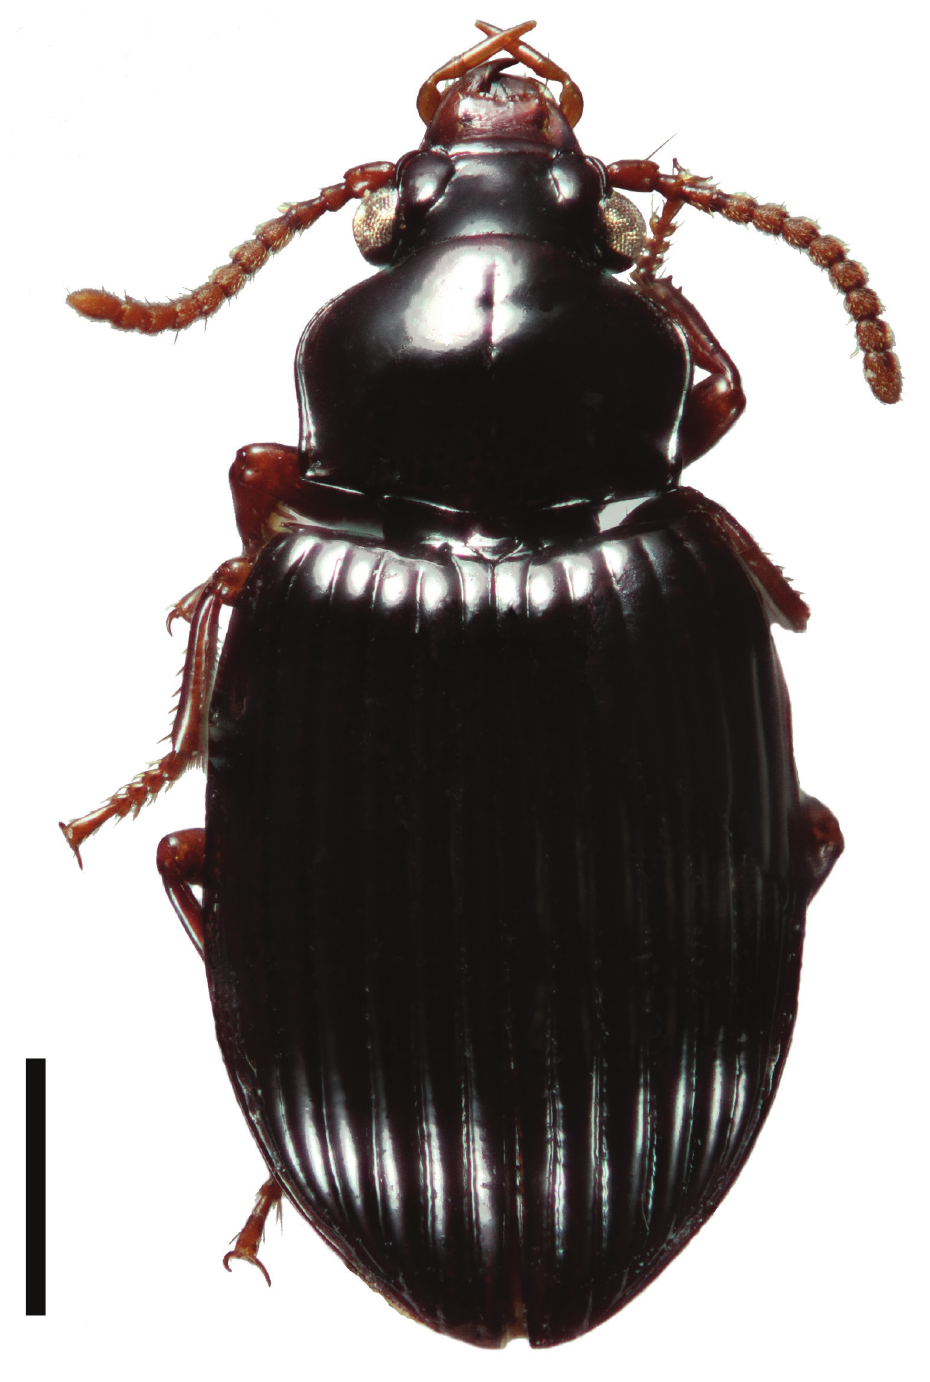
Figure 3. Dorsal habitus image of Cratocerus sinesetosus Grzymala & Will, sp. n. Scale bar = 1.0